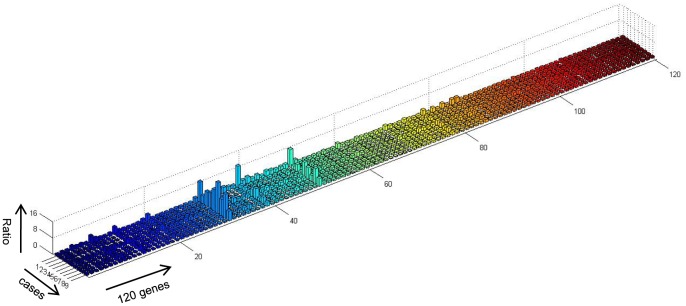
Cytokine antibody array broadly screened for changes in 120 immune mediators in EV71-positive HFMD patients.Cytokine antibody array screened 120 immune factors in 4 mild patients (no neurological syndromes), 5 severe patients (with neurological syndromes), and 2 healthy controls. Data are presented as ratios of the normalized signals for each factor in each of the nine individual patients to the mean concentration obtained from the healthy controls. Data were analyzed by EXCEL and Matlab software.